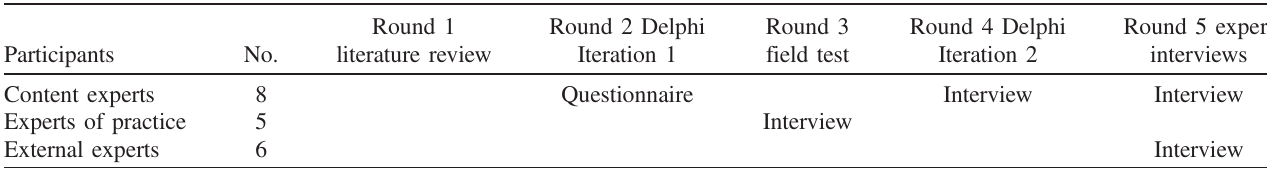
TABLE I. The participants in the modified and augmented Delphi study and the research rounds they were involved